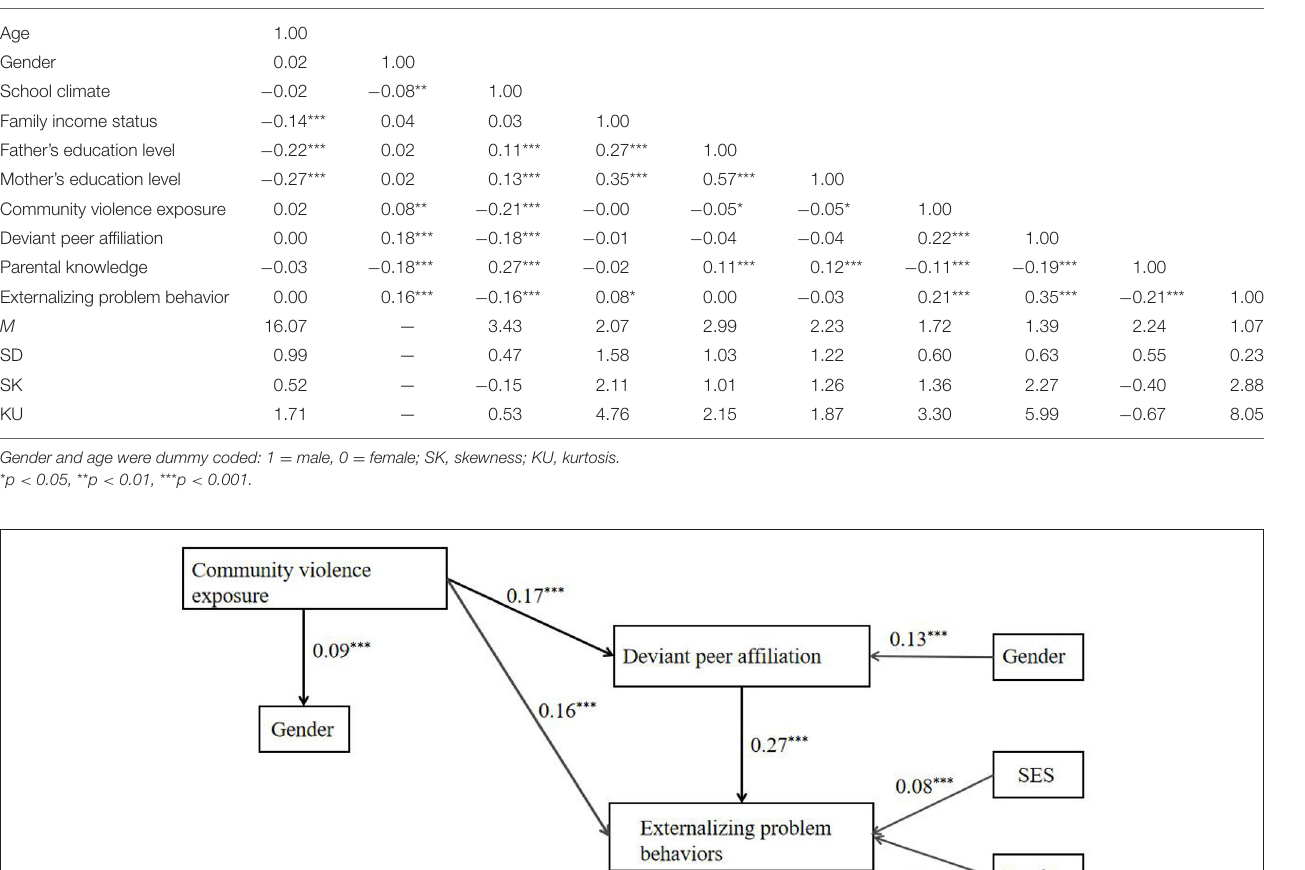
( − 1 SD: Figure 4 : b = 0.35, p < 0.001; Figure 5 : b = 0.30, p < 0.001). On the contrary, a positive relationship